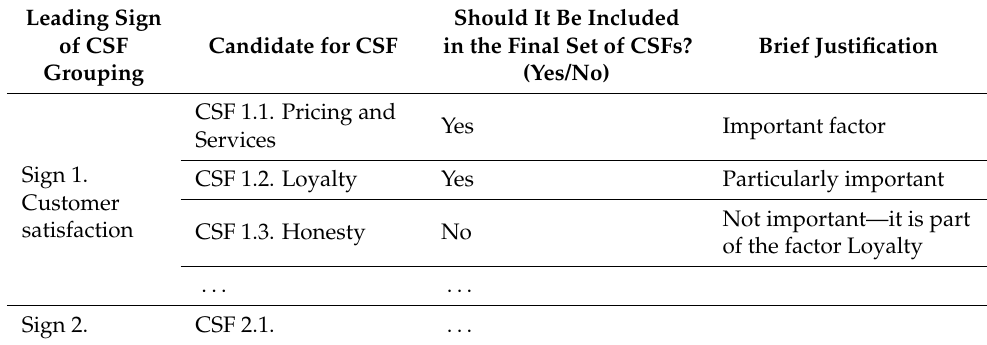
Table 2. Design of CSFs: Form for